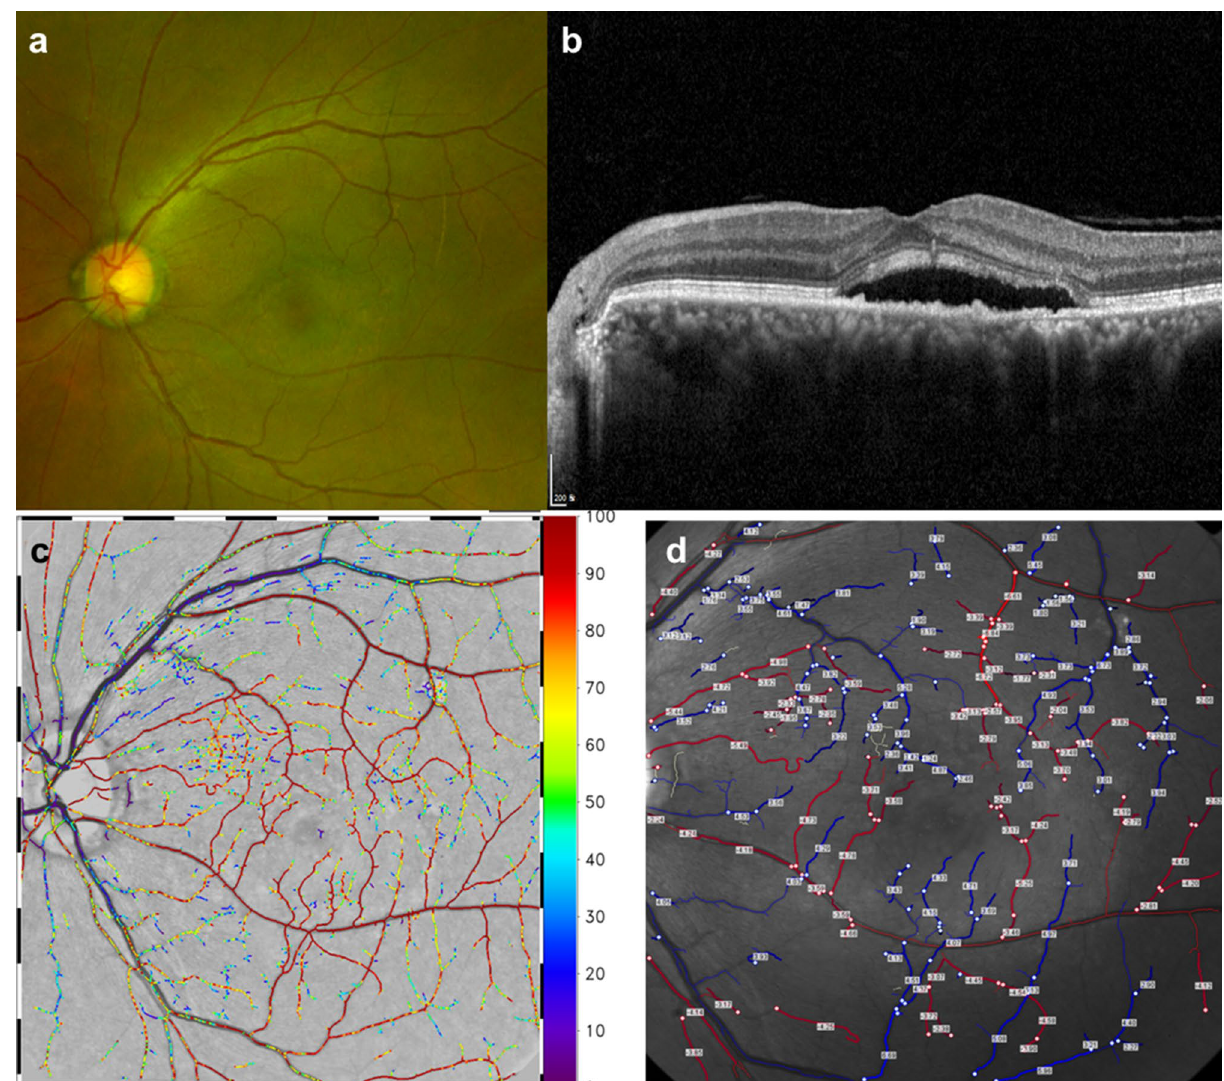
Figure 4. Retinal angiographic images from a case of central serous chorioretinopathy using fundus photography (a) , optical coherence tomography (b) , and retinal functional imager (RFI) (c,d) . (c) O 2 saturation image and (d) retinal vessel velocity